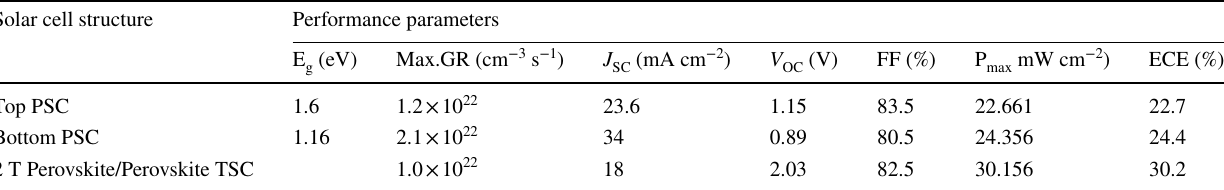
Table 3 Performance parameters for investigated perovskite single‑junction and perovskite/perovskite tandem solar cells using FDTD optical simulation Solar cell structure